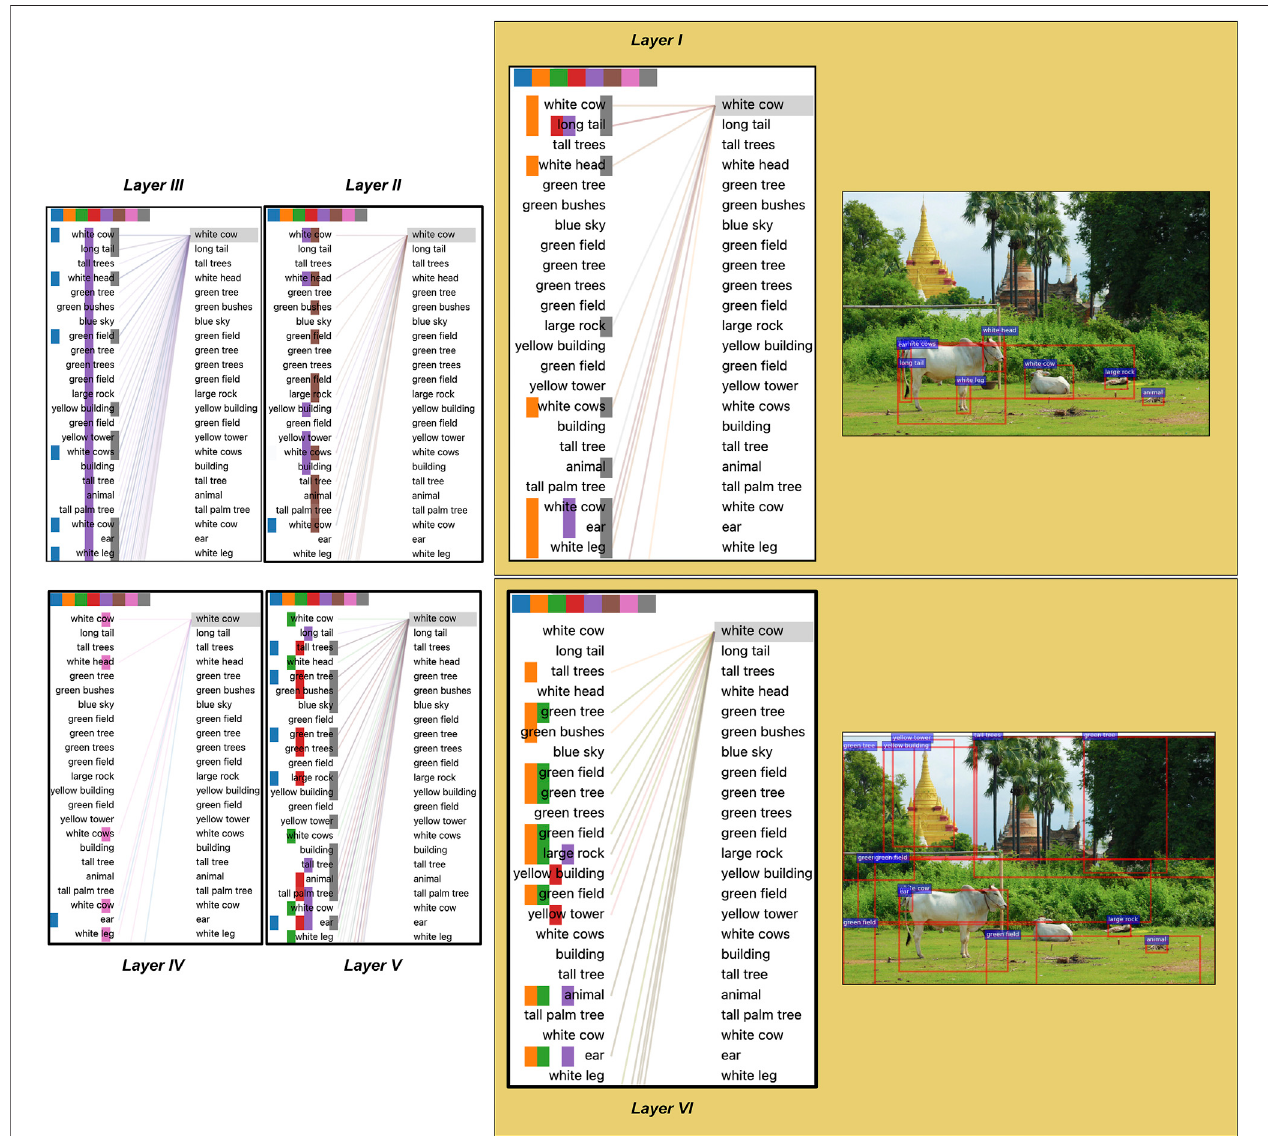
FIGURE 4 | An image with (i) bounding boxes for a subset of detected objects (in red), and with (ii) visual self-attention connections for all six layers between this subsetof36objects.Captionfortheimage: “ twocowsoutside,onelayingdownandtheotherstandingnearabuilding ” .Differentlycolouredsquaresontopofeachlayer visualisation indicate different attention heads. Each layer is displayed with two identical lists of objects: the left column shows the source objects, while the right column depicts the target objects which receive attention from source